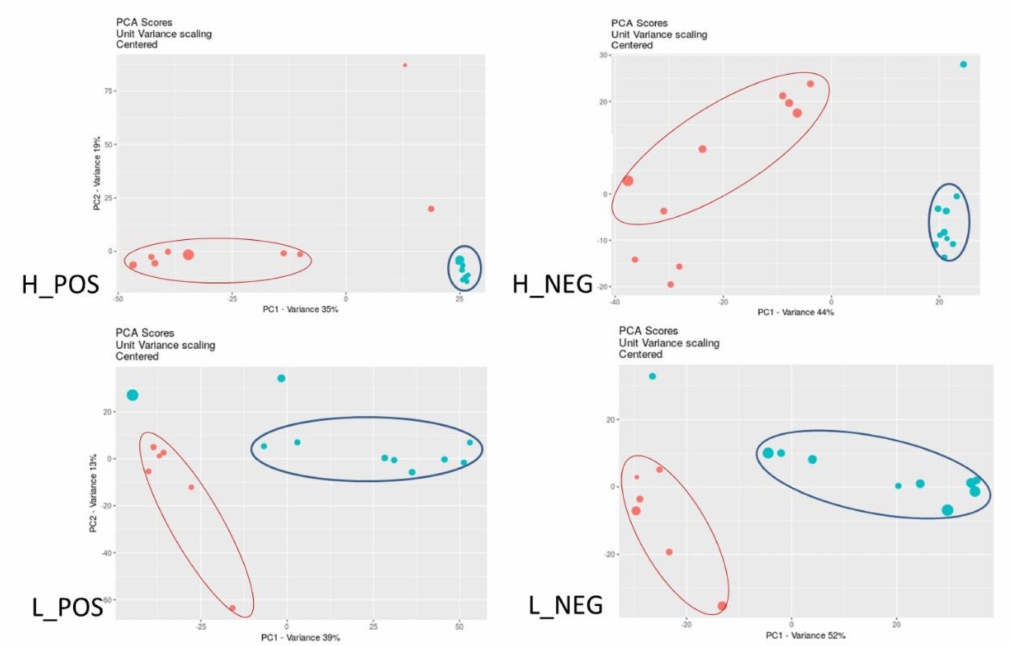
Figure 2. Principal component analysis (PCA) plot of the features detected in test (cinnamaldehyde) and control (untreated) cultures of Mtb; hydrophilic (H) and lipophilic (L) extract; positive (POS) and negative (NEG) mode. Red dots–untreated samples, blue dots–cinnamon essential oil / cinnamaldehyde samples, circles indicate grouped point sets.